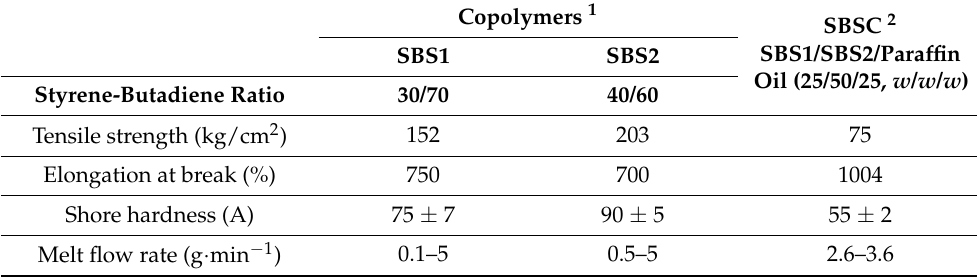
Table 2. Physicomechanical characteristics of SBS 1 and SBS 2 copolymers vs. SBS